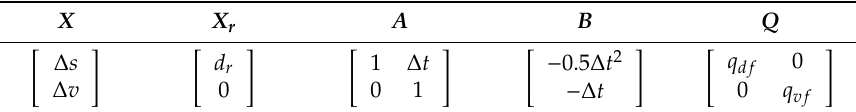
Table 3. MPC model for deceleration planning.